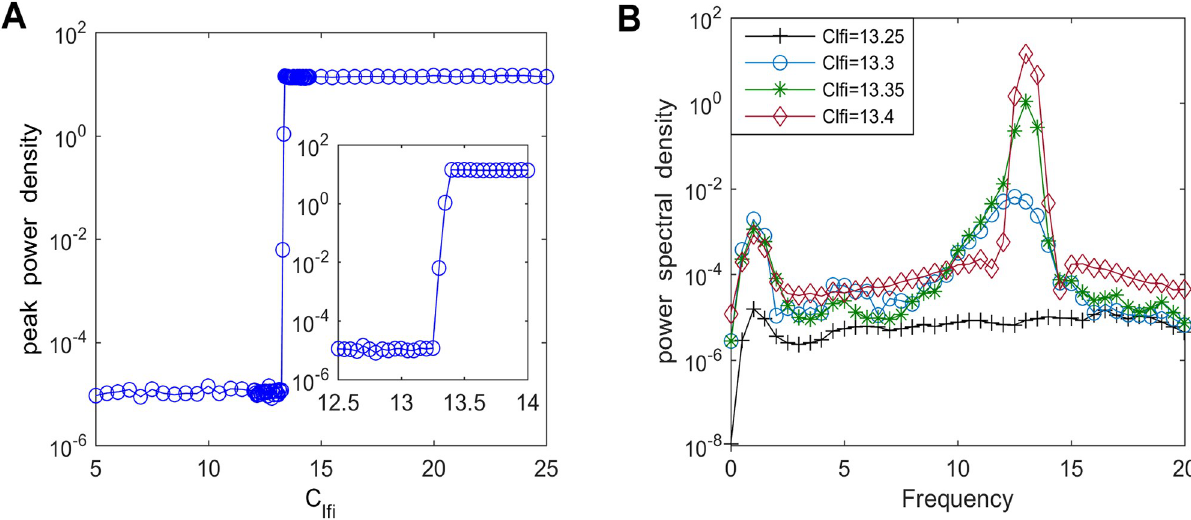
Fig 6. The peak power density and the corresponding power spectral density for varying values of C band of the thalamic module. (B) The corresponding power spectral density for different values of C lfi such as C lfi = 13.25, 13.3, 13.35, 13.4.